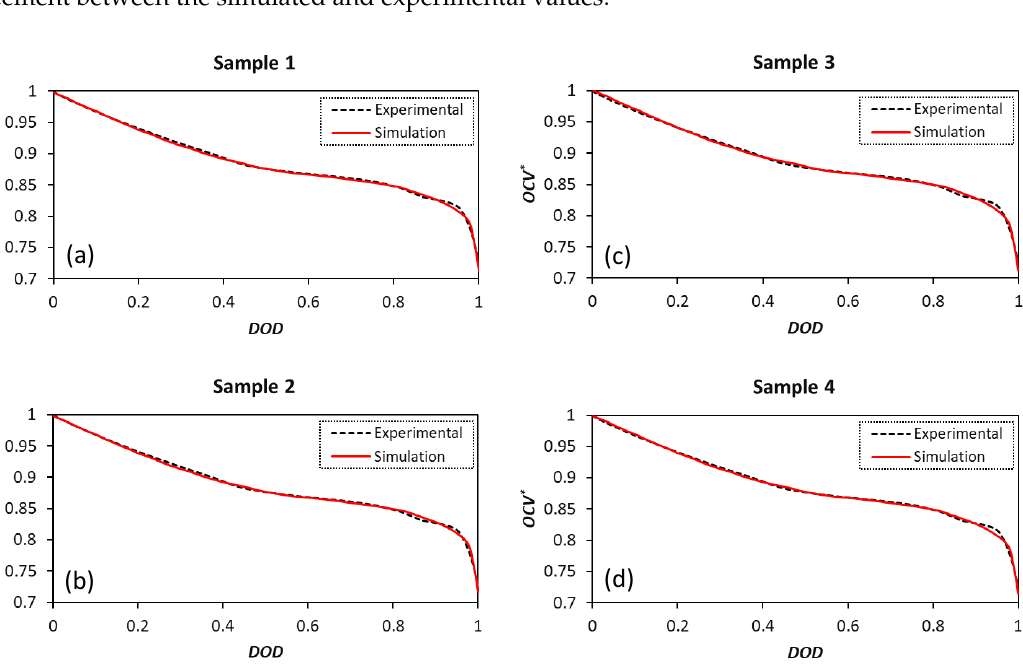
Figure 4. OCV calibration optimization results for four cell samples. ( a ): sample 1; ( b ): sample 2; ( c ): sample 3; ( d ): sample